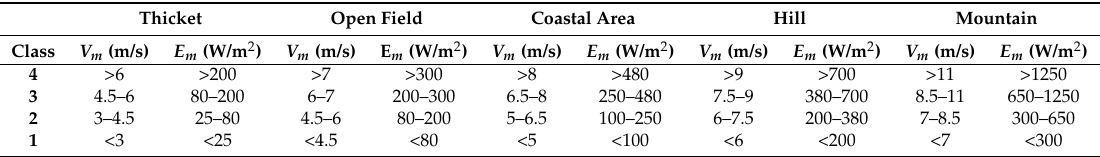
Table 1. Definition of wind energy classes. In class 1 the probability of success in the installations is extremely low. Class 4 occurs in environments with greatest wind potential. Classes 2 and 3 have intermediary energy potentials. Source: Adapted from Feitosa